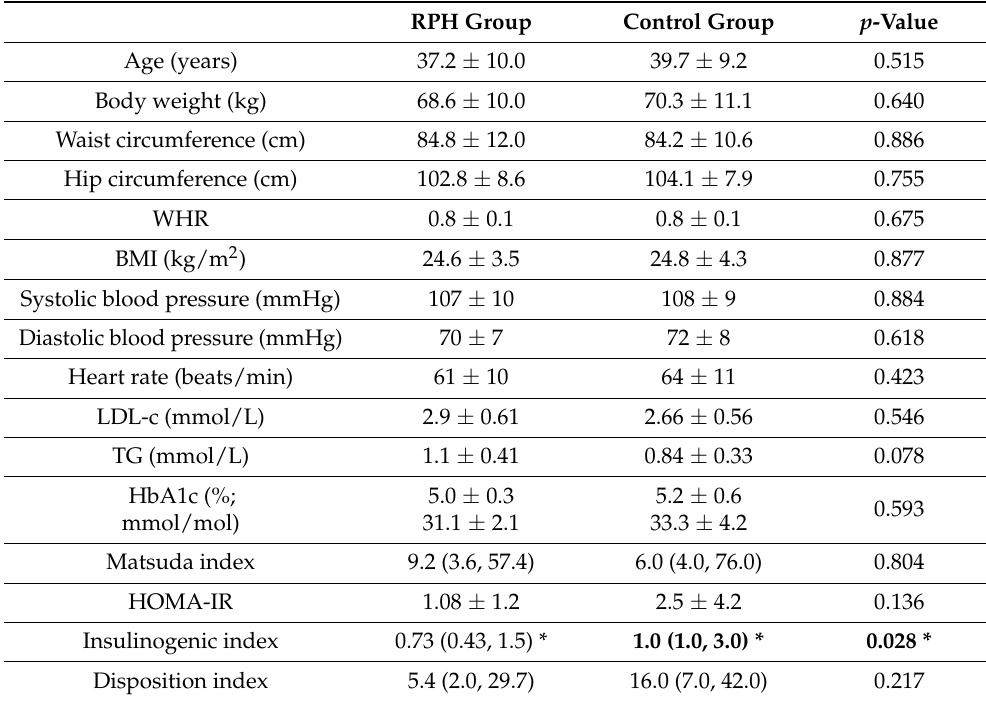
Table 2. Comparison of relevant anthropometric and biochemical characteristics of subjects in the RPH group vs. the control group.